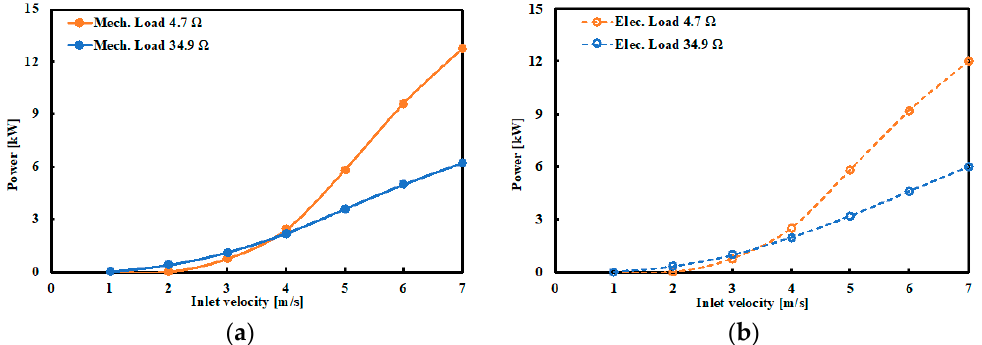
Figure 19. Power at different rotational speed.